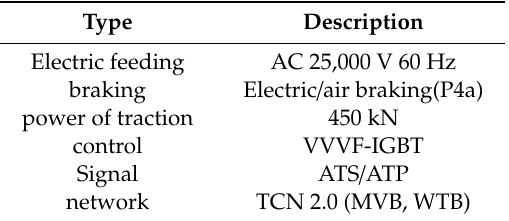
Table A1. ID 8500 Locomotive specifications.